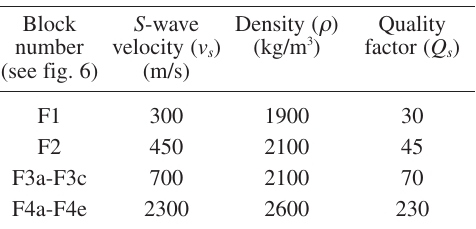
Table I. Physical parameters of the blocks used in the 2D finite-difference modeling. Block